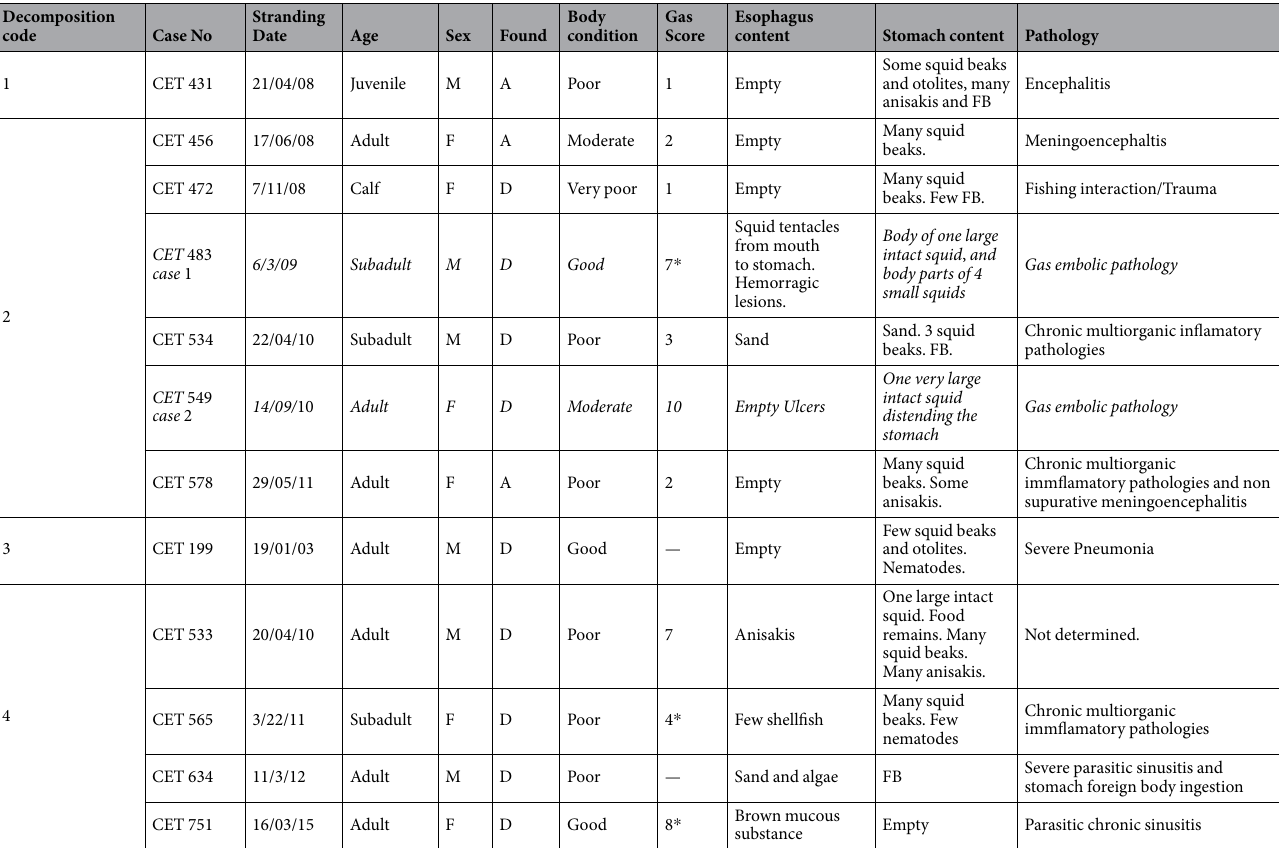
Table 1. List of Risso’s dolphins with complete pathological studies within the study period (2000–2015). Asterisks indicate dolphins on which one localization was not adequately observed for bubbles, thus the gas score could potentially be up to 2 points higher in these animals if bubbles were present on that